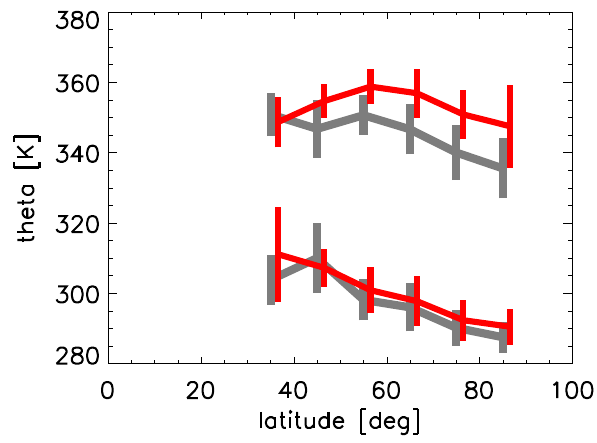
Fig. 13. Annual mean location of the upper and lower boundaries of a chemical defined ExTL. The boundaries are determined following the method in Hegglin et al. (2009) on the basis of H 2 O (red) and CO (grey) as observed from the ACE-FTS instrument.